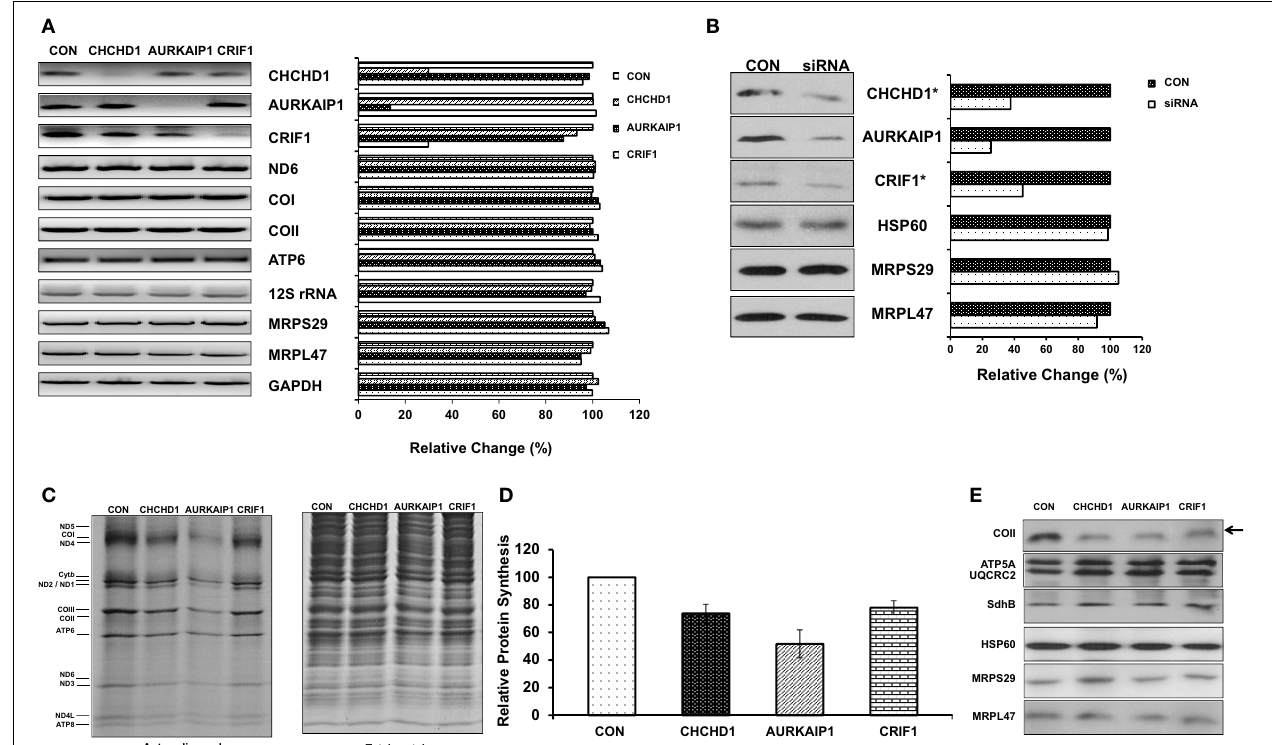
FIGURE 4 | Role of CHCHD1, AURKAIP1, and CRIF1 knock-down on mitochondrial protein synthesis. (A) Transcript levels of CHCHD1, AURKAIP1, and CRIF1 were shown as an indication of knock-down efficiency in cell lines transfected with control siRNA and siRNAs for corresponding new MRPs. Mitochondrial encoded ND6, COI, COII, ATP6, and 12S rRNA, and nuclear encoded MRPS29 and MRPL47 were examined by RT-PCR reactions in the same samples. RT-PCR reactions with GAPDH were performed as a positive control and relative quantitation of signal intensities was calculated based on GAPDH mRNA levels (or siRNA control cell line) in each knock-down cell line. (B) Expressionlevelsof newMRPsin controlsiRNAandMRP-specific siRNA transfected HEK293T cell lysates and total crude ribosome fractions ( ∗ ) were analyzed by immunoblotting using antibodies against AURKAIP1, CHCHD1, CRIF1, MRPS29, MRPL47, and HSP60. Immunoblotting analyses with HSP60, MRPS29, and MRPL47 antibodies were used as loading controls for total protein and total ribosome content using whole cell lysates obtained from control and AURKAIP1 siRNA knock-down cells. Similar results were obtained with immunoblotting analyses of total crude ribosome fractions from CHCHD1 and CRIF1 siRNA knock-down cell lines using HSP60, MRPS29, and MRPL47 antibodies (data not shown). (C) De novo synthesis of mitochondrial